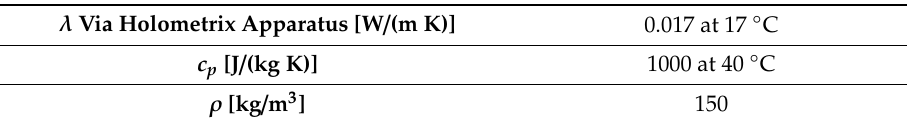
Table 1. The material properties